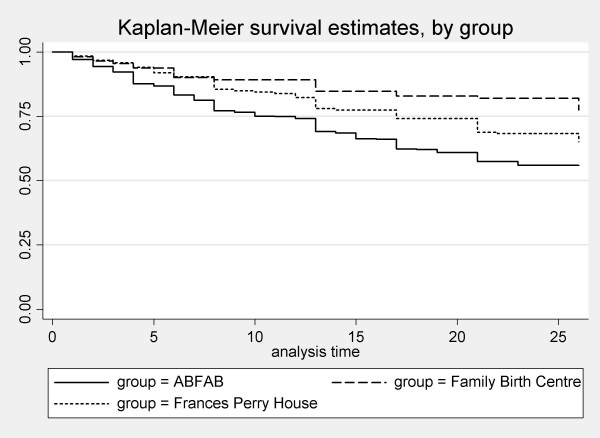
Duration of any breastfeeding, by group.